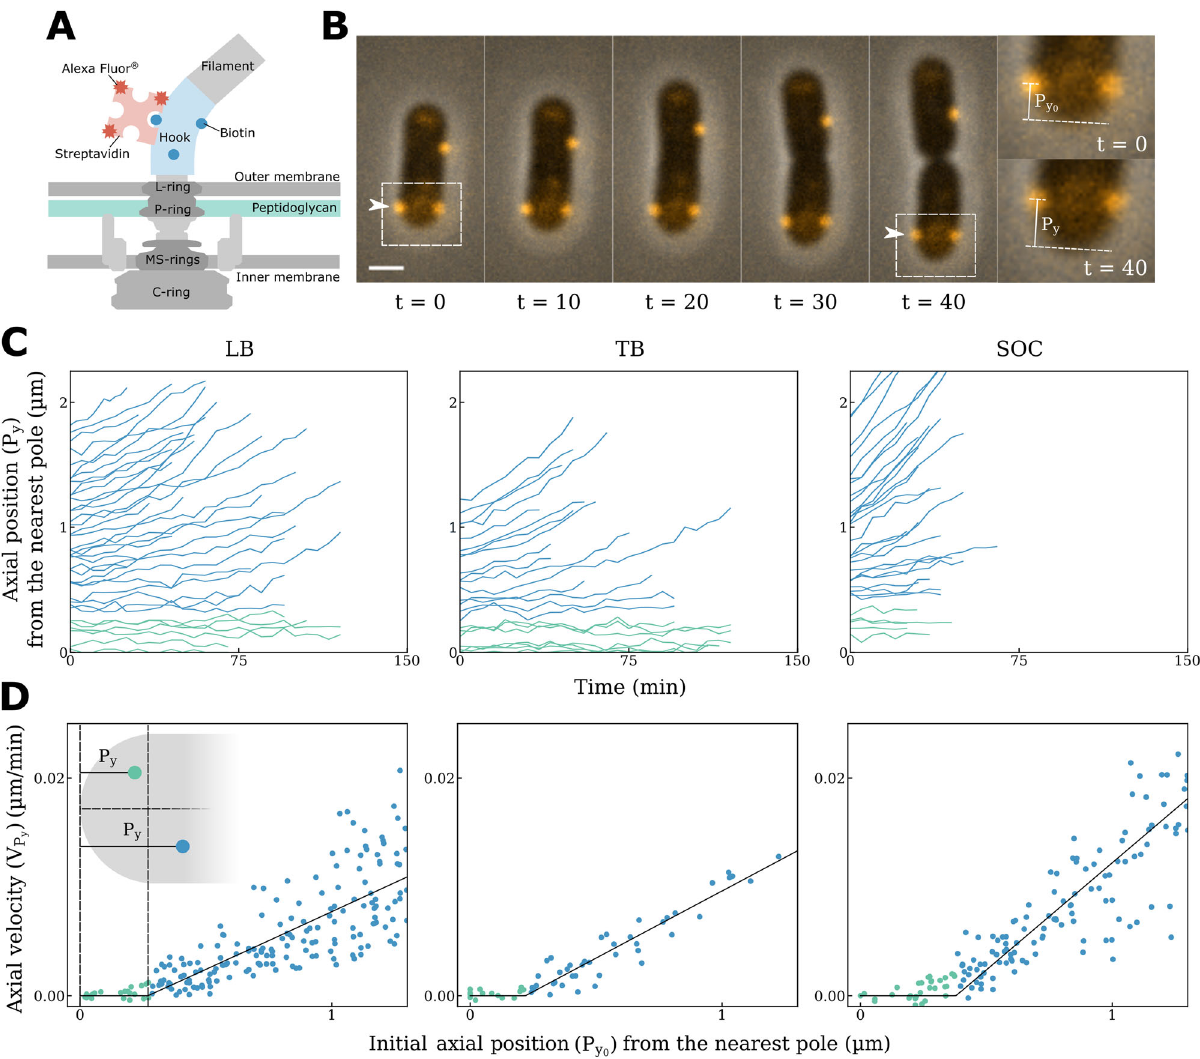
Fig. 1 Real-time monitoring of E. coli cell wall growth using fl uorescently labeled fl agellar motors (BFMs) as landmarks. A A schematic showing the fl uorescent labeling of a bacterial fl agellar hook with Alexa Fluor 594. B Time-lapse fl uorescence images showing the dynamic movement of BFMs in actively growing cells. Fluorescence and phase-contrast images were overlaid (scale bar, 1 μ m; Δ t = 10 min). At least 3 times of the same experiment was repeated with similar results. C Sample traces tracking the axial positions ( P y ) of BFMs during cell elongation in different growth media (LB: n = 45; TB: n = 22; SOC: n = 31). Green and blue lines represent BFMs within the inert zone and the active zone, respectively. D Average velocity of BFM movement during cell growth identi fi ed an inert zone near the cell poles in different growth media. Green dots: BFMs in the inert zone; blue dots: BFMs in the active zone; Total number of tracked fl agellar motors, LB: n = 195; TB: n = 56; SOC: n = 220); inset: a schematic showing the P y of a BFM from the nearest cell